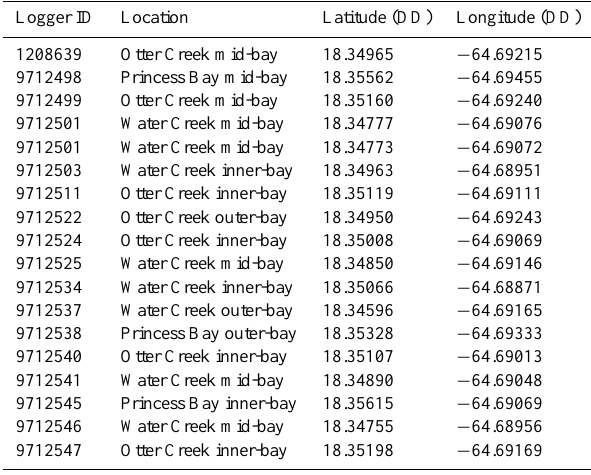
Table 2. Location of HOBO temperature loggers in Hurricane